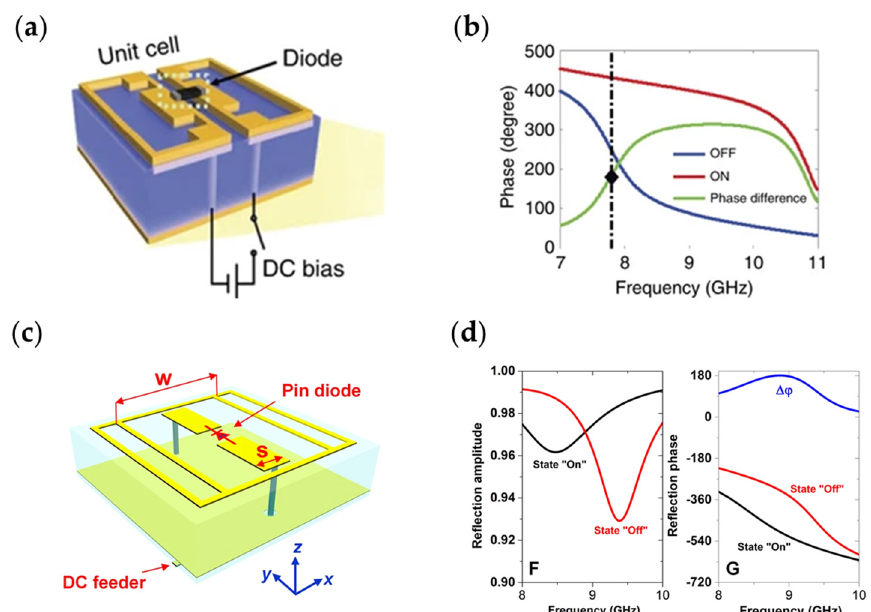
Figure 6. ( a ) and ( b ) Schematics of two typical metasurface-embedded PIN diodes; ( c ) and ( d ) The Figure 6. ( a , b ) Schematics of two typical metasurface-embedded PIN diodes; ( c , d ) The electromag- electromagnetic responses corresponding to ( a ) and ( b ), respectively. netic responses corresponding to ( a ) and ( b ),